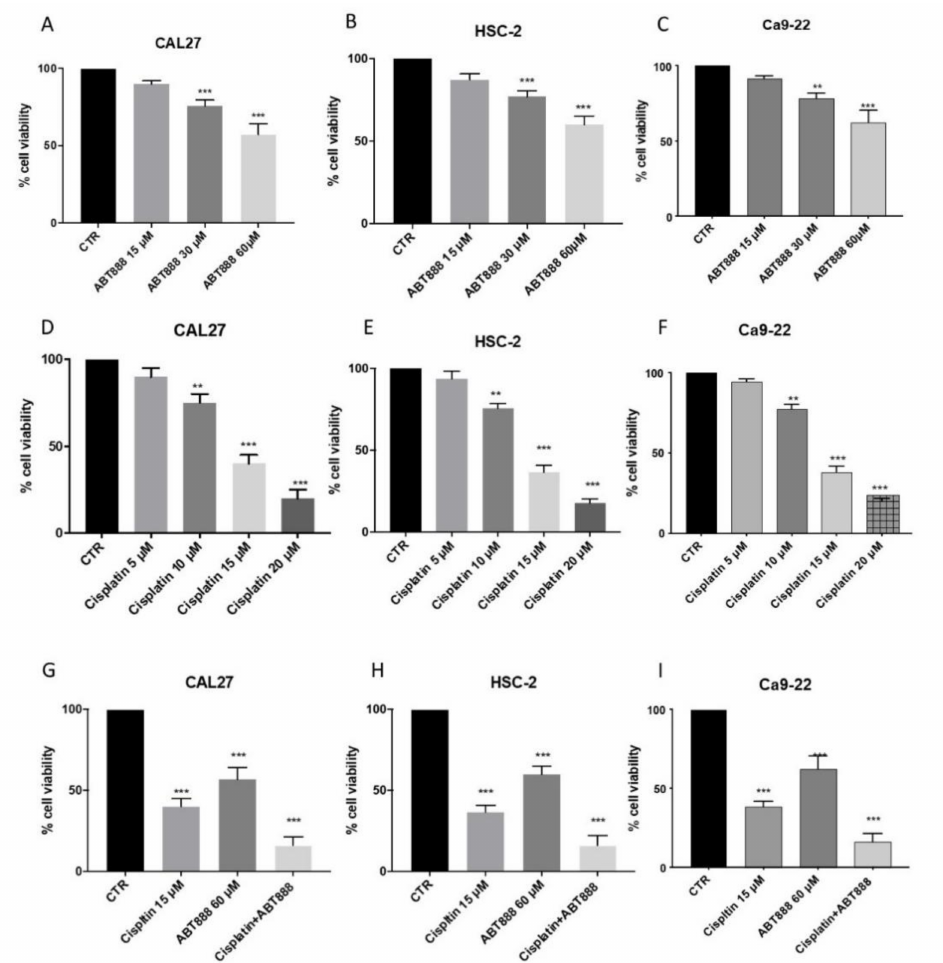
Figure 1. Effect of ABT888 on cell viability. Cell viability was assessed using MTT assay 24 h after treatment with ABT888 (15 µ M, 30 µ M, 60 µ M) and cisplatin (5 µ M, 10 µ M, 15 µ M and 20 µ M). HSC-2, CAL27 and Ca9-22 cell lines showed a decrease in viability following ABT888 and cisplatin treatment, in particular at the lowest concentration (Figure A–F, respectively). Figures G, H and I showed that ABT888 at a concentration of 60 µ M increased the cytotoxicity effect of cisplatin in all the cell lines. Data are representative of at least three independent experiments. ( A ) *** p < 0.001 vs. the